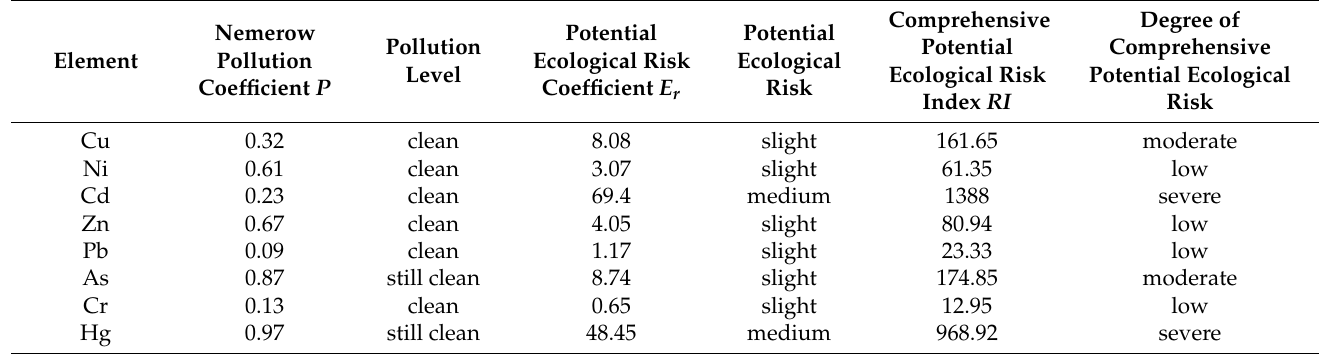
Table 7. Average pollution level and ecological risk grade of each heavy metal in sludge.